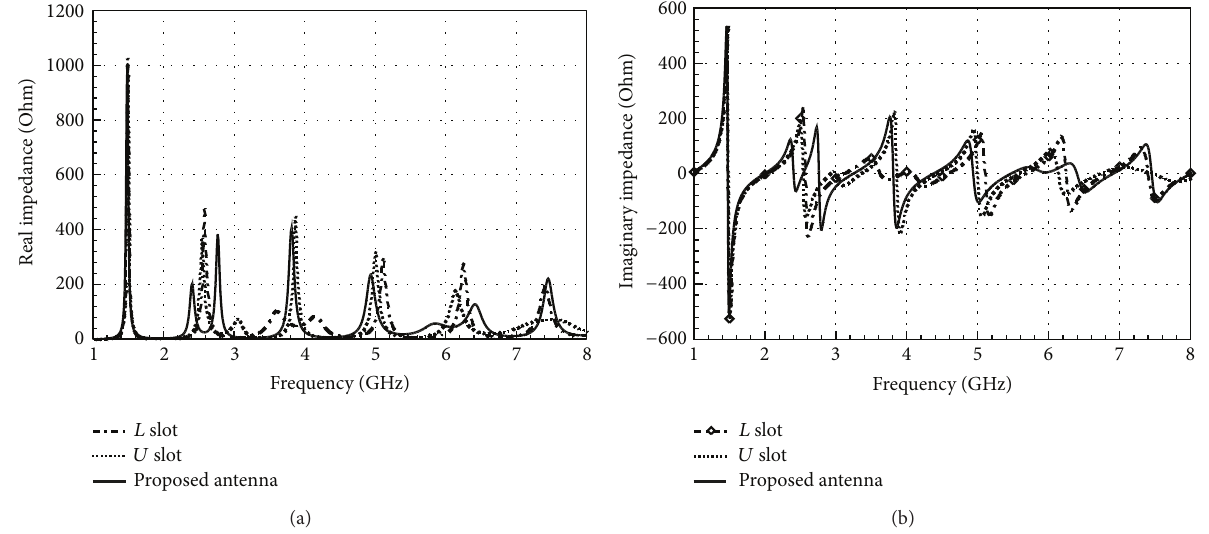
Figure 5: Simulation results of proposed slit shaped (a) real and (b) imaginary